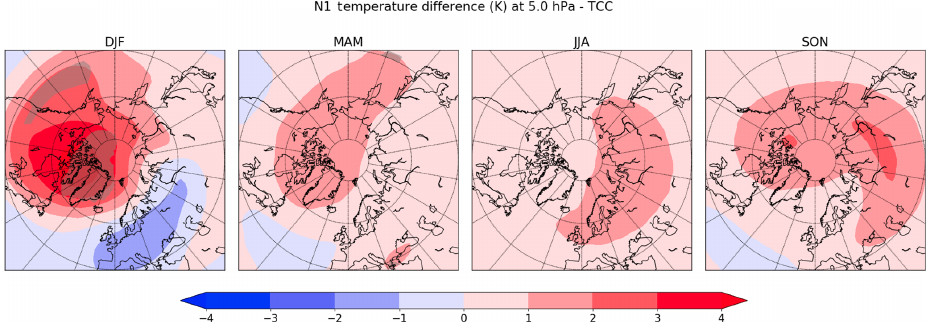
Figure 3. Northern Hemisphere seasonal differences in stratospheric temperature (high-Ap–low-Ap values) at 5hPa after applying the correction for serial dependence (TCC). Grey areas indicate statistically significant areas at the 5% confidence level.